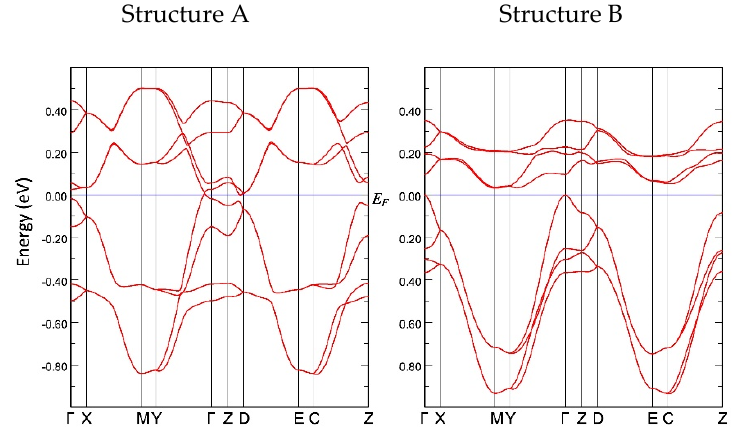
Figure 8. Fermi surfaces in [Pd(dddt) 2 ] at 5.9 GPa, 7.8 GPa and 10.6 GPa.